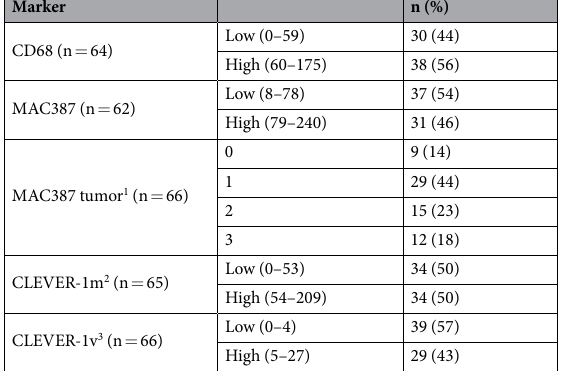
Table 2. Marker counts from TUR-BT sections. Groups dichotomized according to the mean value. 1 MAC387 and lymph vessels.